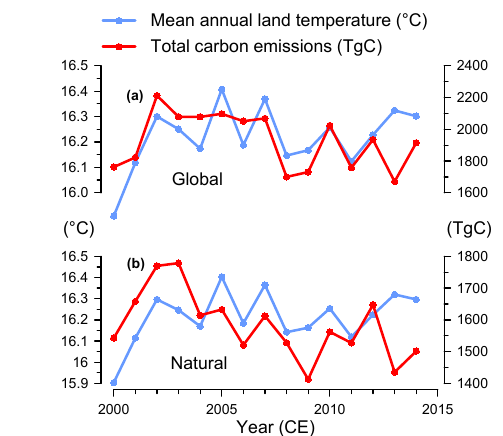
Figure 2. Co-evolution of temperature and fire-related emis- sions over the period between 2000 and 2014. The temperature data are from the NOAA data set (NOAAGlobalTemp v4.0.1; doi10.7289/V5FN144H; Vose et al., 2012) and the emissions data are from GFED4 (Randerson et al., 2015, www.globalfiredata.org, last access: 16 February 2018). The top panel (a) shows global tem- perature (in blue) and emissions (in red) after excluding agricultural areas; the bottom panel (b) shows temperature (in blue) and emis- sions (in red) from areas of natural vegetation only, excluding both deforestation fires and peatland fires.